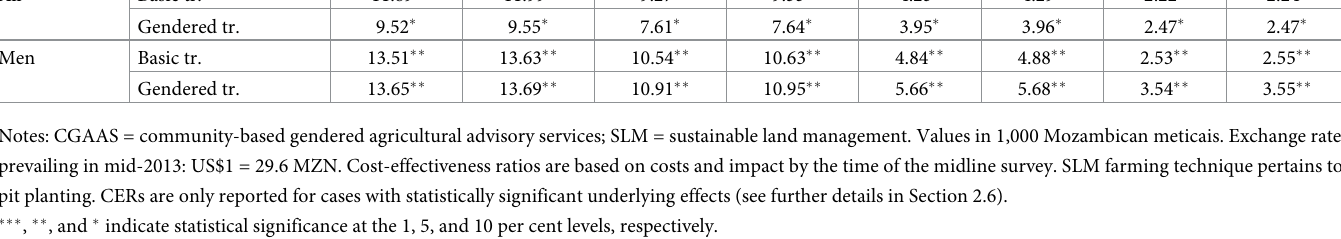
Table 9. CGAAS: Cost-effectiveness in increasing adoption of SLM farming technique. Treatment arm Central Gender All Basic tr. Men Basic tr. Gendered